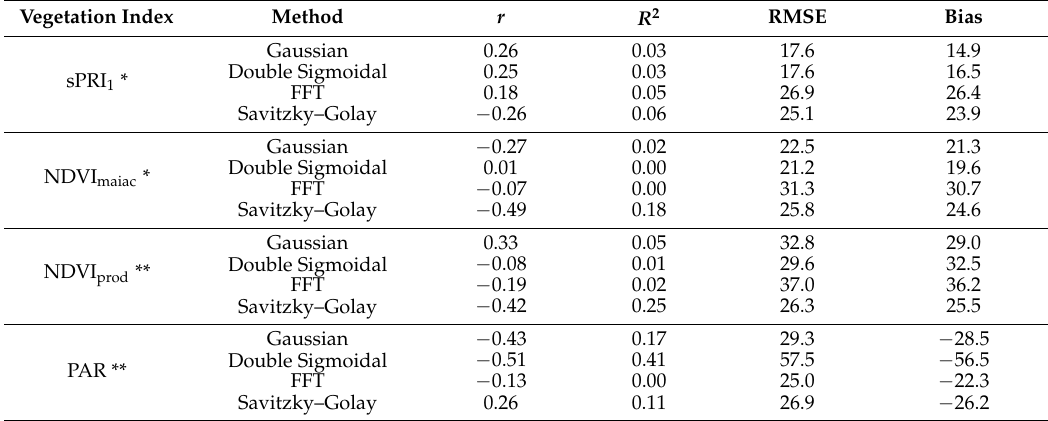
Table 4. Statistics of correlation between the end of the growing season (EGS) derived from ground measured NEE and EGS derived from MODIS VI time series and PAR. R 2 : Coefficient of determination; r : rho from Spearman Rank’s correlation; RMSE: Root mean squared error. All tested relationships were insignificant ( p -value > 0.05).